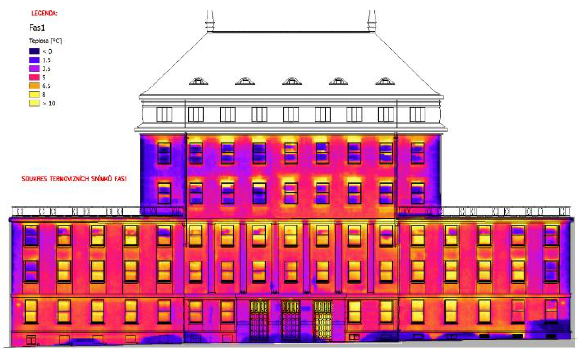
Figure 6. Thermal inspection layer included in MISYS SPRÁVA BUDOV.